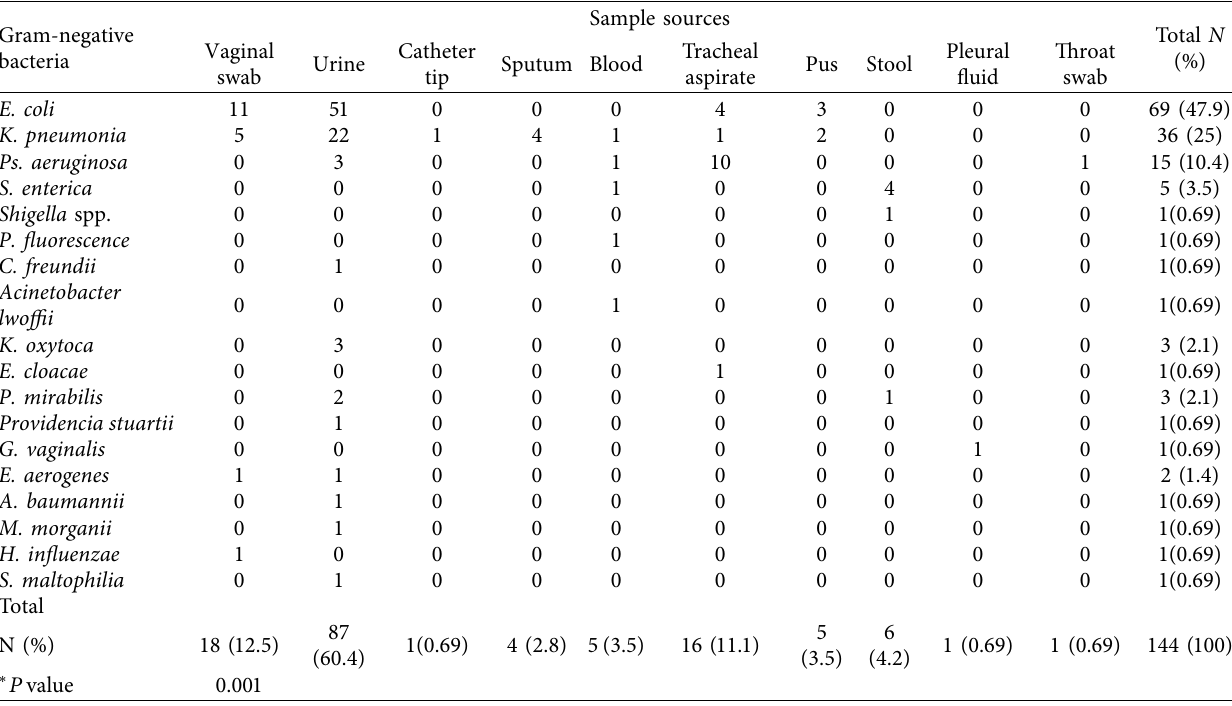
Table 1: Distribution and relationship between isolates and source of samples.